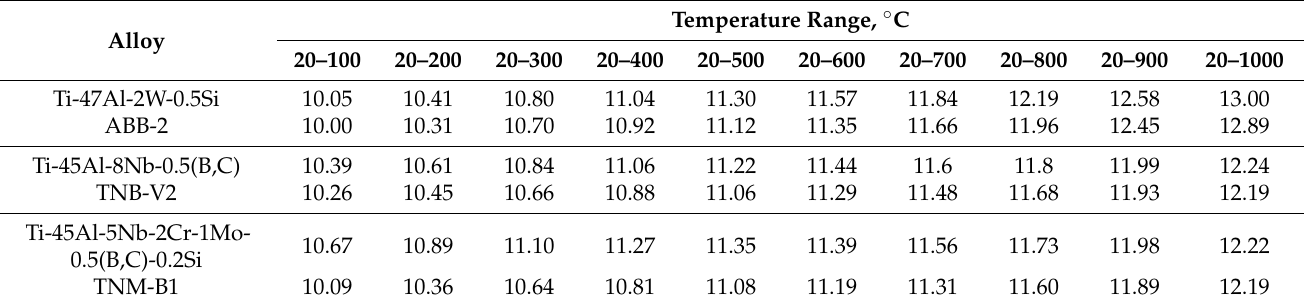
Table 3. Thermal expansion coefficient of produced and reference alloys, 10 − 6 / ◦ C.